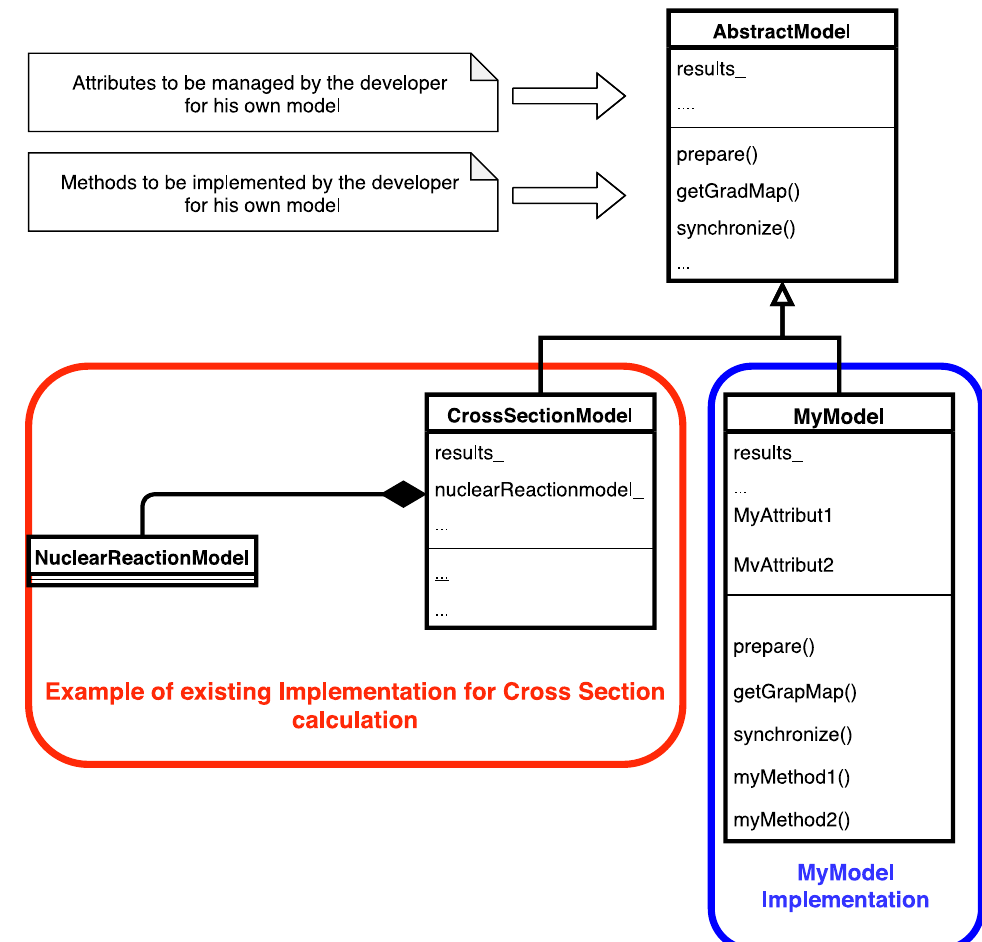
Fig. 1. UML diagram description of CONRAD AbstractModel interface. The API for model implementation (called specialization) is